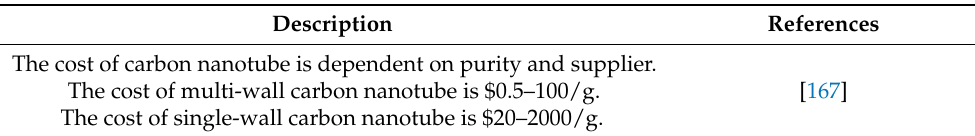
Table 13. The preparation costs and operation costs of carbon